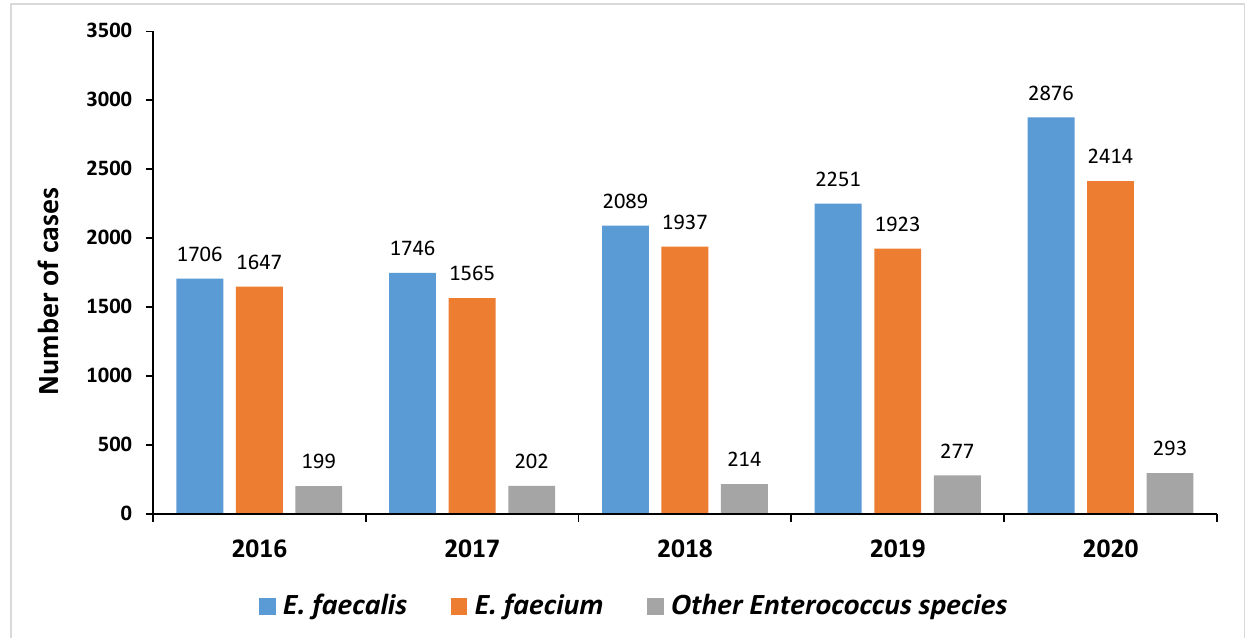
Figure 3. Distribution of cases with Enterococcus species isolated from blood cultures in South Africa from 2016 to 2020 ( n = 21,339). Other enterococci included: E. avium , E. casselifalvus , E. cecorum , E. columbae , E. durans , E. gallinarum , E. hirae , E. raffinosus , and E. species